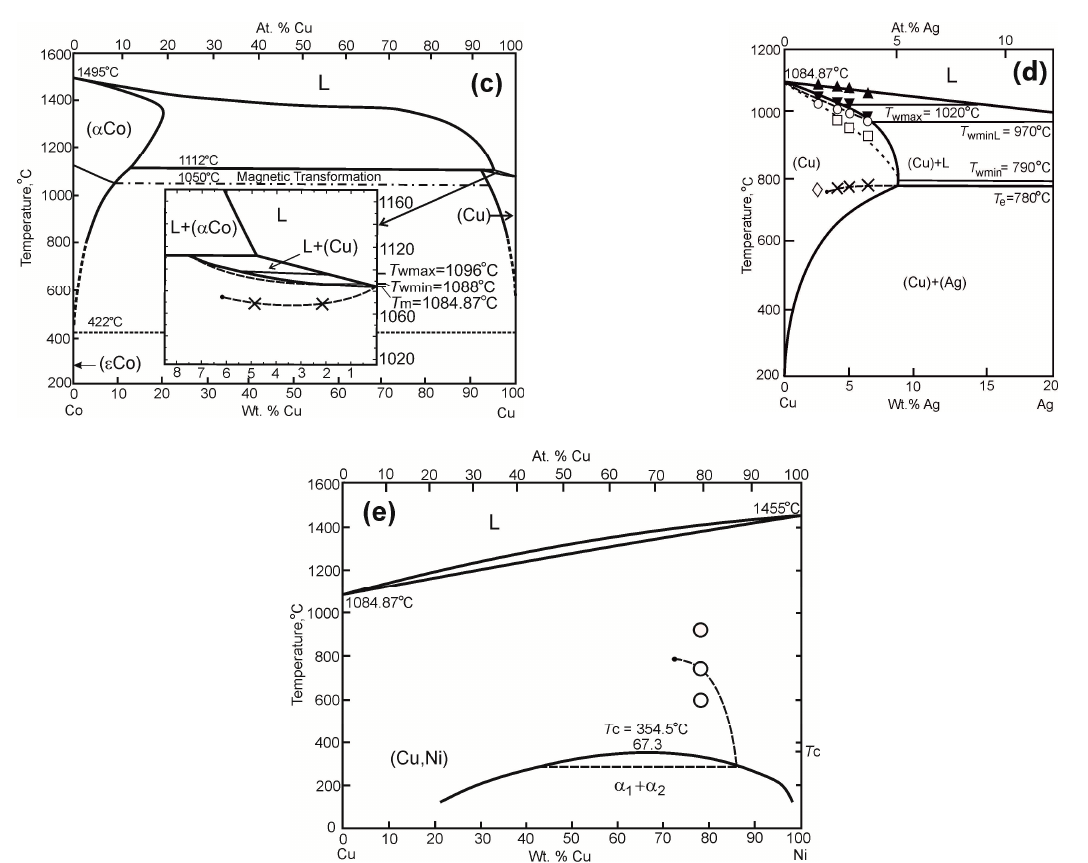
Figure 2. The bulk phase diagrams of the systems ( a ) Al-Zn, ( b ) Al-Mg, ( c ) Cu-Co, ( d ) Cu-Ag, and ( e ) Cu-Ni with lines of bulk phase transitions [151]. T w —grain boundaries (GB) wetting phase transformation by liquid phase, T ws —GB wetting phase transformation by solid phase.